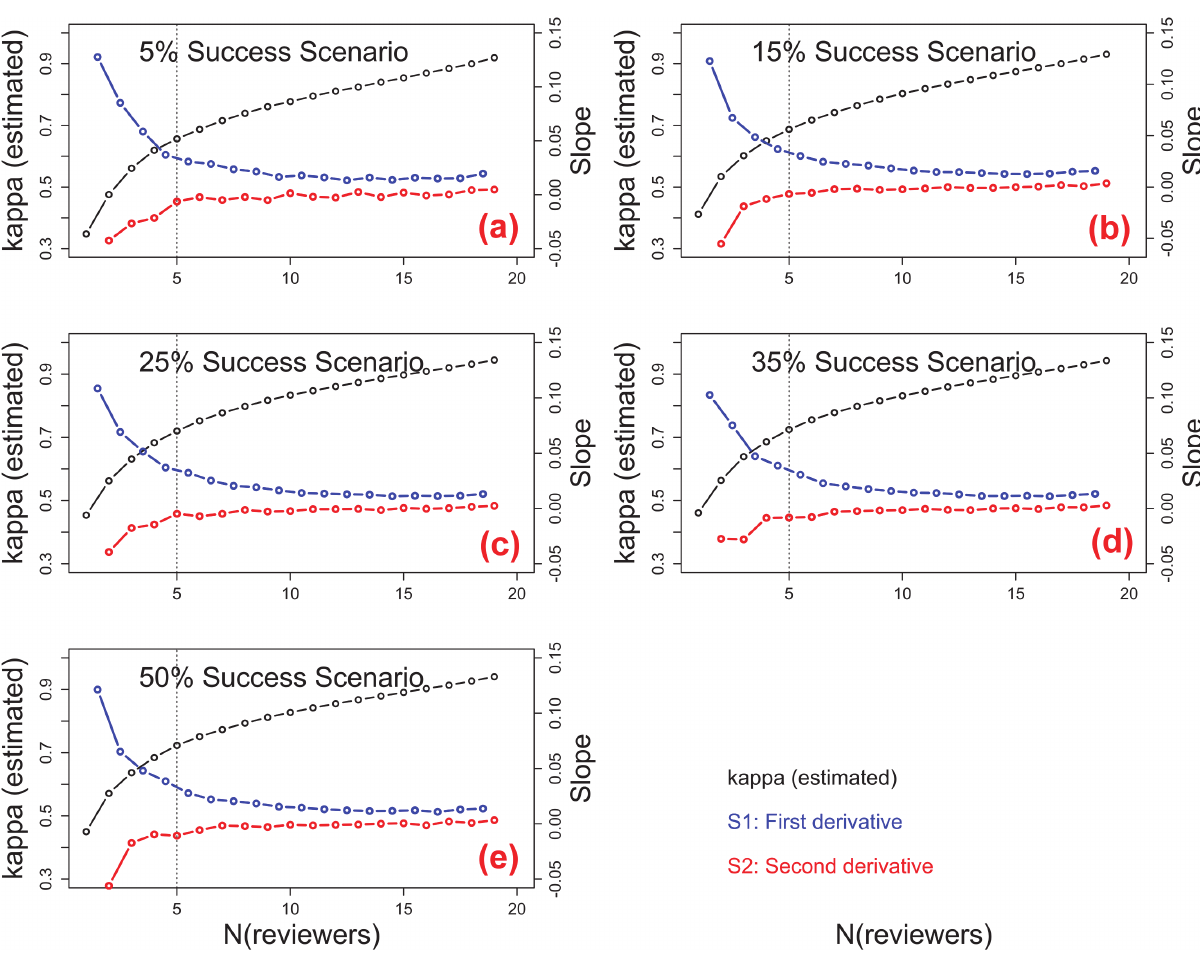
Fig 5. First derivative (S1) and second derivative (S2) of kappa, within incremental N to N+1 reviewers, across five overall competition success rate scenarios. Relative improvement of kappa reached stability at 4 – 5 reviewers per application or shortly thereafter, across all overall success rate scenarios [5% (a), 15% ( b ), 25% (c), 35% (d), and 50% (e)]. Vertical dashed lines represent the approximate S2 asymptotes.